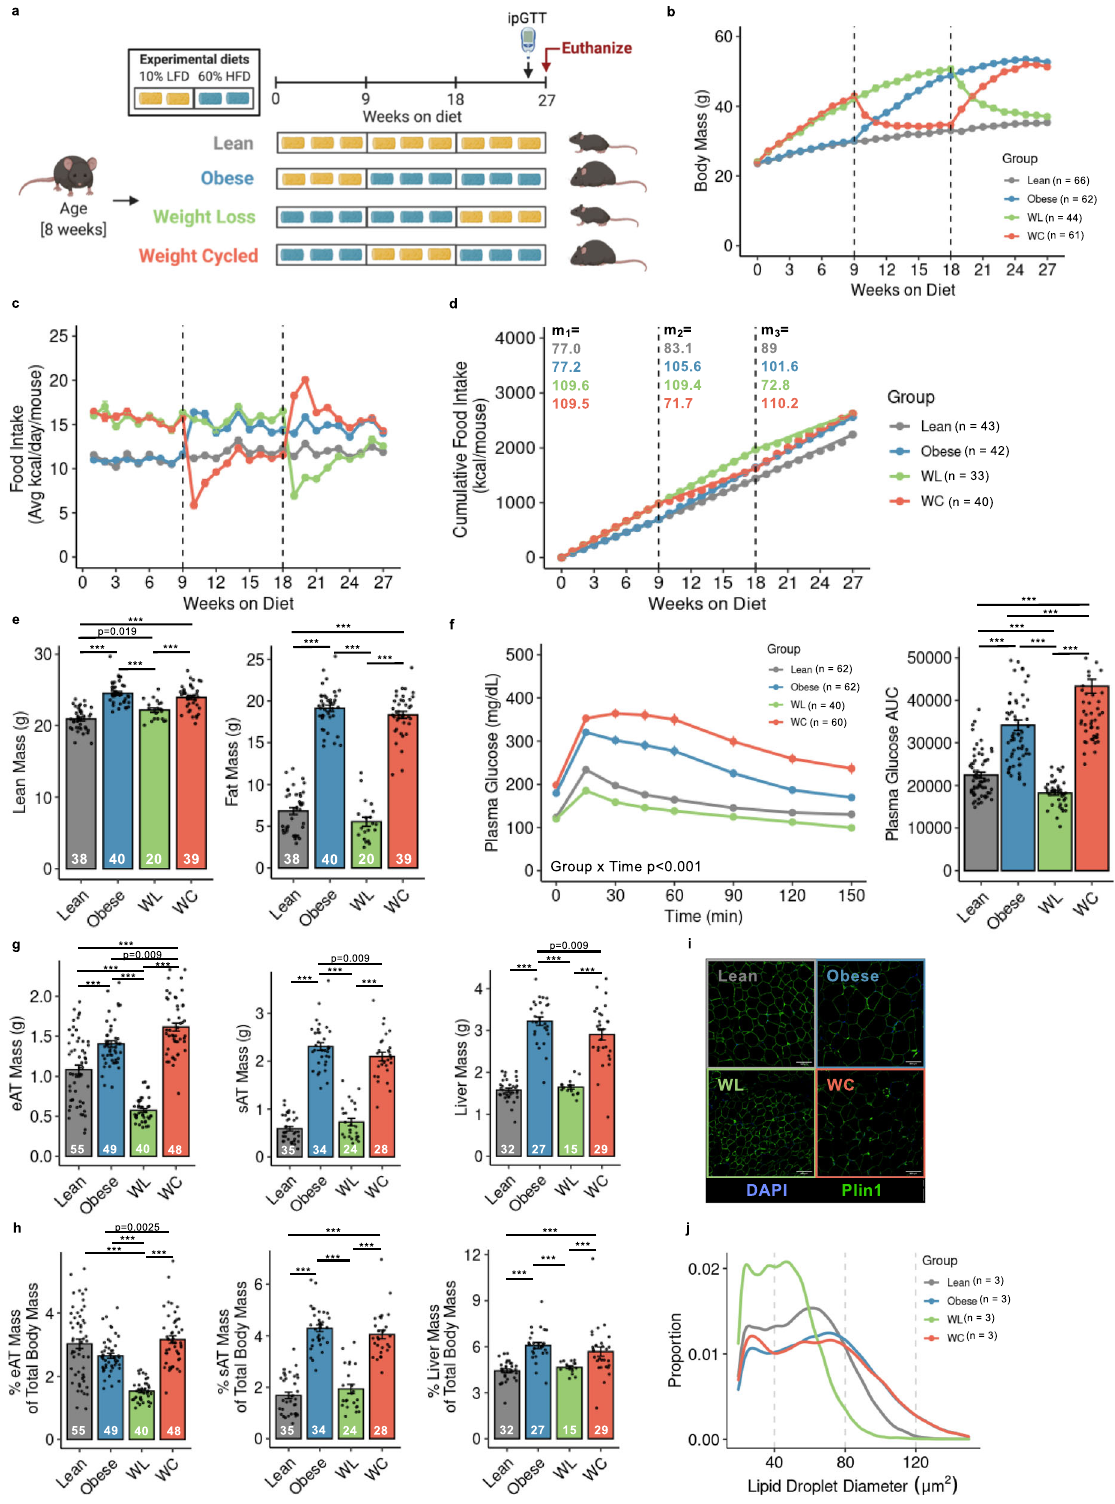
surface proteins to pool and index 4 biological replicates per group. Cells were isolated via collagenase digestion, CD45 + magnetic enrichment, and FACS for viability before preparation for sequencing using the 10X Chromium platform (Fig.